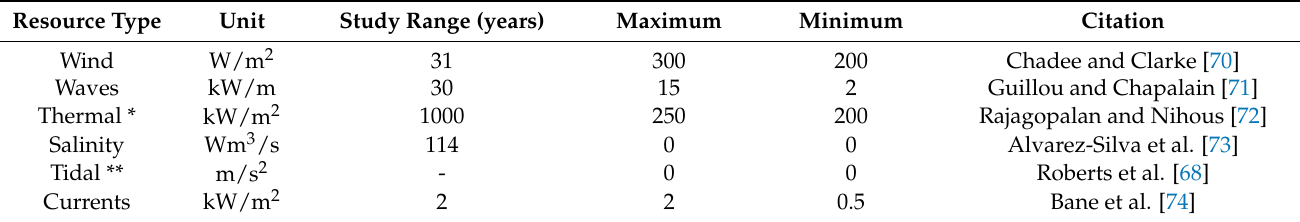
Table 1. Energy resource densities for The Bahamas collated from the